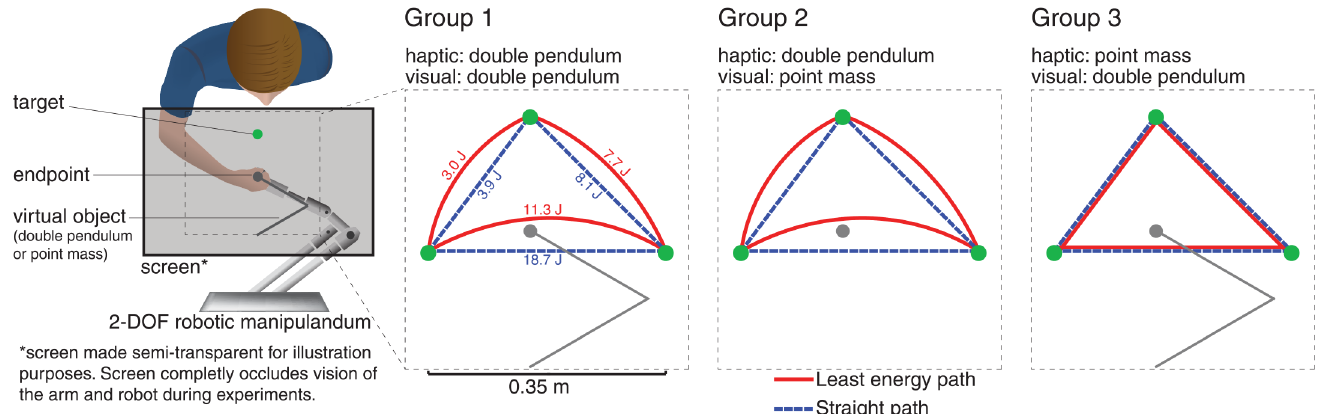
Fig 1. Experiment design. Straight and least energy paths between each pair of targets in the task space coordinate